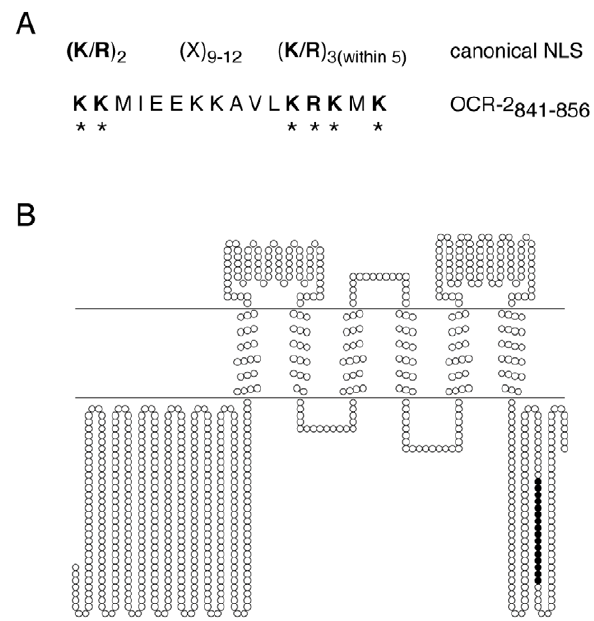
Figure 1. A putative bipartite NLS in the TRPV channel OCR-2. Amino acids 841–856 of OCR-2 contain two clusters of lysine/arginine residues, separated by 9 amino acids. (A) Alignment with the canonical bipartite nuclear localization sequence demonstrates that the OCR-2 sequence closely matches an NLS. (B) A diagram of the C. elegans OCR-2 channel, with the putative NLS in black, reveals that the sequence is located in the cytoplasmic carboxy-terminus of the channel. The cytoplasmic side is located below the horizontal lines that denote the plasma membrane. (Diagram was created using TOPO2, Transmem- brane Protein Display software, http://www.sacs.ucsf.edu/TOPO2).